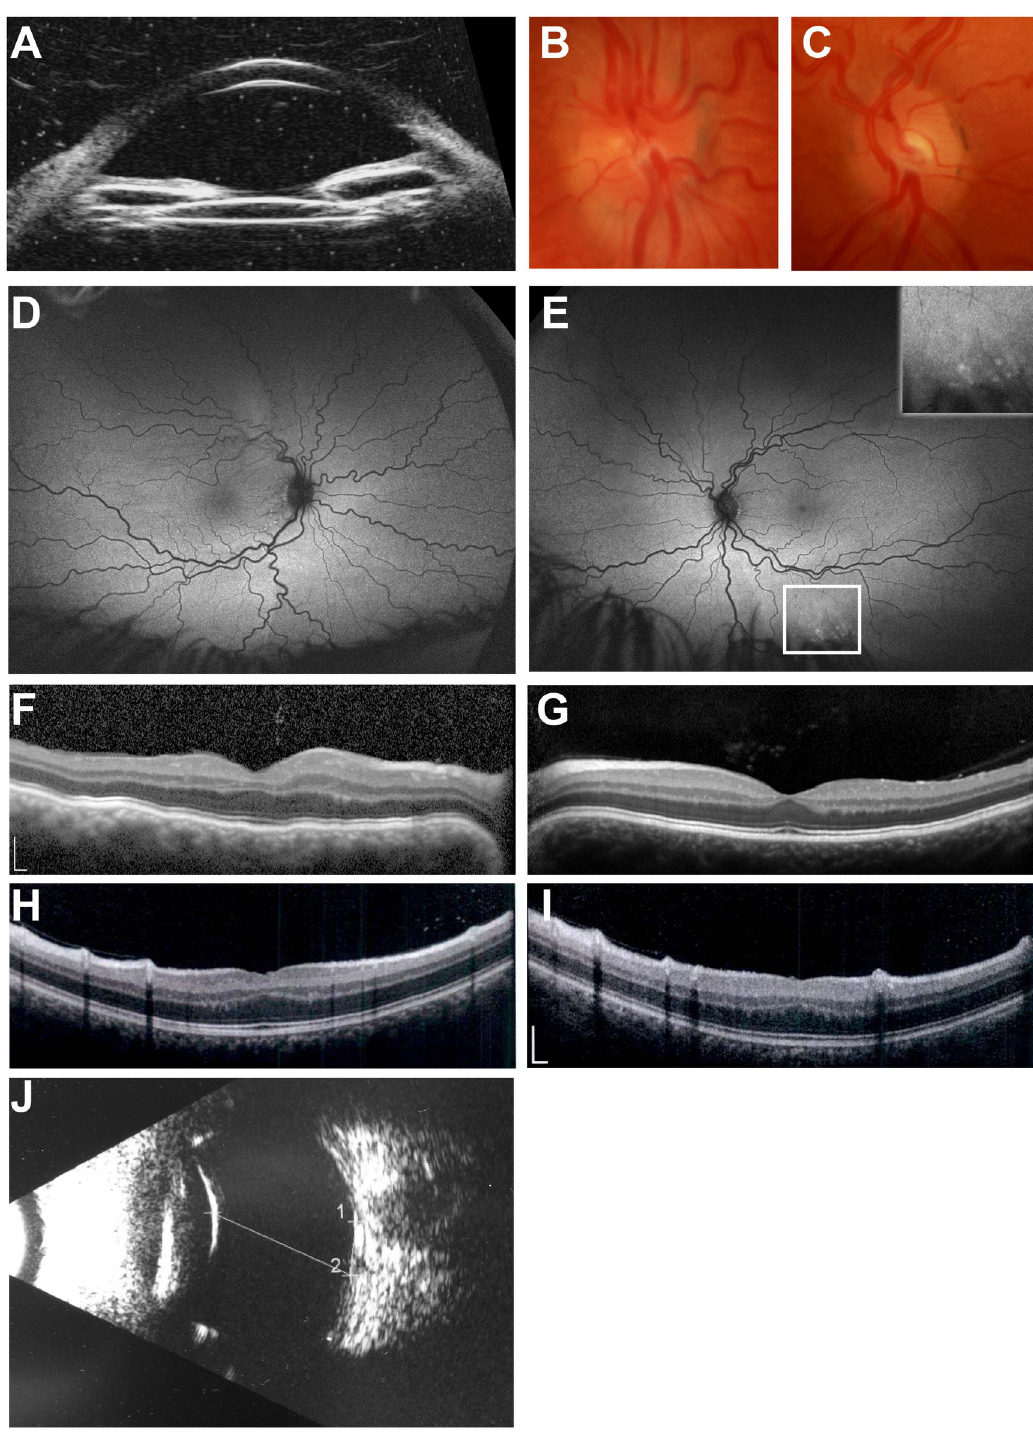
Fig 1. Clinical features of individuals in this study. (A-G) NNO1 family member clinical imaging. (A) Ultrasound biomicroscopy showing shallow anterior chamber and narrow angles. (B-C) Optic disc photos of the right (B) and left (C) eye showing crowded discs with vascular tortuosity. (D-E) Wide-field 200-degree Optos autofluorescence images of right (D) and left (E) showing tortuous vasculature and highlighting small area of hyperfluorescence in the left eye below the inferiotemporal arcade. (F-G) SD-OCT images of right (F) and left (G) eye showing choroidal folds in the right eye and otherwise normal foveal structure. (H-J) Sporadic nanophthalmos case clinical images. (H-I) SD-OCT of right (H) and left eye (I) eye showing mild foveal hypoplasia. (J) Bscan ultrasound showing short axial length and reduced posterior segment dimensions (line). Scale bar, 200 μ m.